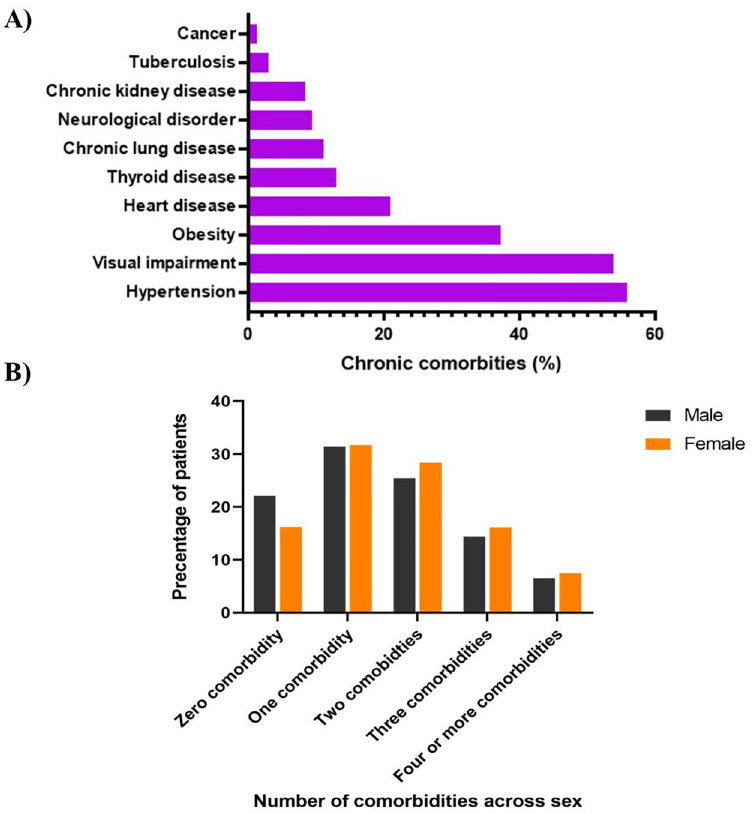
Fig 1. Frequency of various comorbidities among diabetes patients of the southern part of Bangladesh. A) Frequency of various comorbidities; B) Number of comorbidities present in males and females.